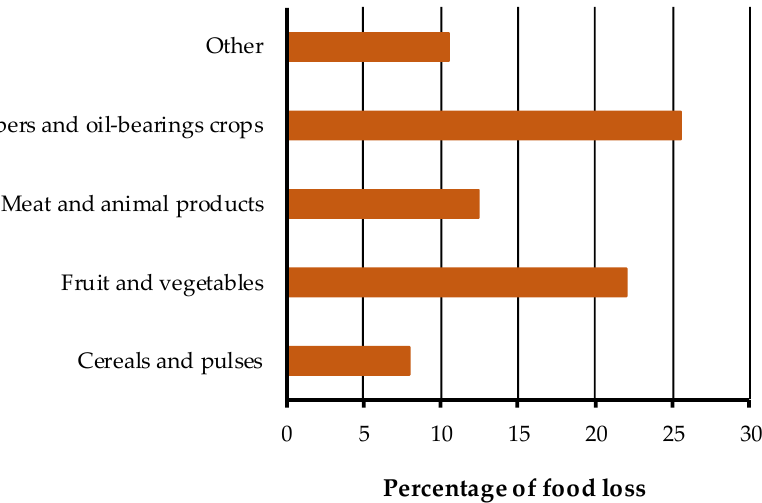
Figure 2. Food losses and waste along the supply chain (percentage for each food group).